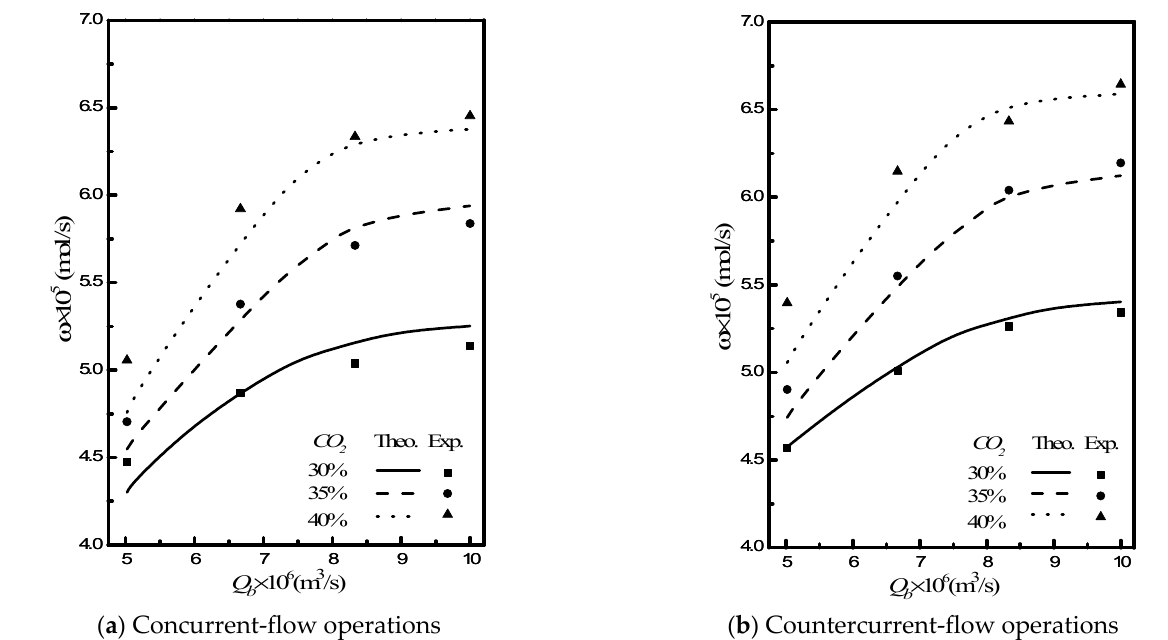
with absorbent flow rate and inlet CO 2 concentration in both concurrent- and countercur- rent-flow operations, as indicated in Figure 8 for comparison. The results show that the CO 2 absorption rate increases with the absorbent flow rates. Meanwhile, the CO 2 absorp- tion rate is higher in countercurrent-flow operations than that in concurrent-flow opera- tions, as shown in Figure 8. The higher absorbent flow rate and inlet CO 2 concentration obtain a higher CO 2 absorption rate as predicted above accordingly.